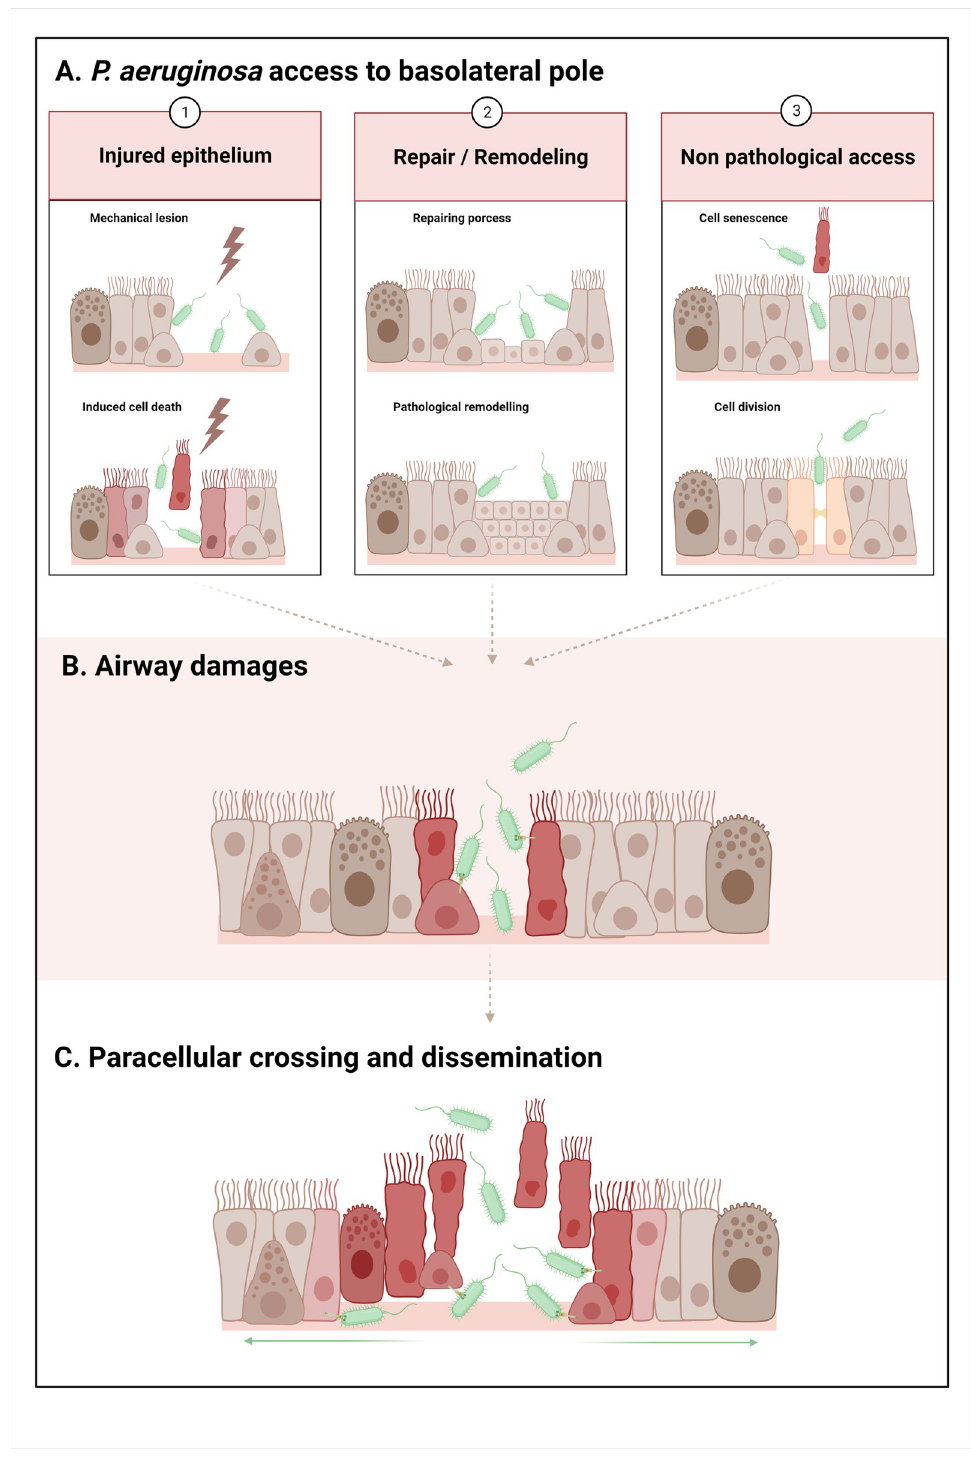
Fig 2. P . aeruginosa basolateral interaction and progression in the airway epithelium. A. In the first step of infection, P . aeruginosa gains access to the basolateral part, exploiting various opportunities: 1. Injured epithelium: a. Mechanical lesion: removal of HAE cells and denudation of the basement membrane. Ex: endotracheal tube in VAP. b. Induced epithelial cell death: dying cells undergo retraction, tight junction disruption, and detachment from the adjacent cells and the basement membrane. The injury could be caused by pathogens (viruses, bacteria, etc.), chemical injury (pollutants,